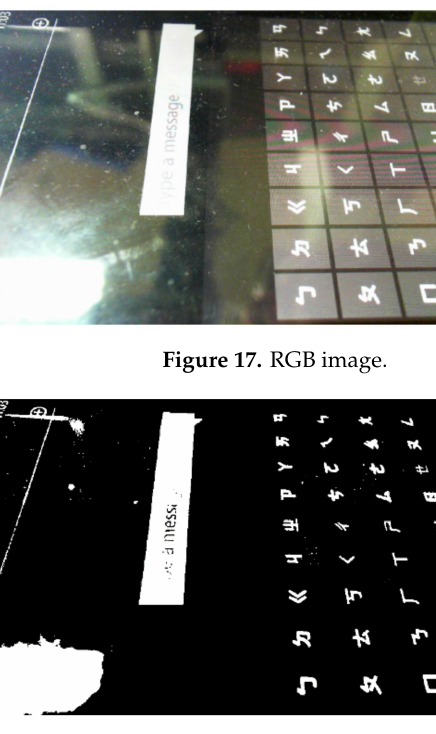
Figure 18. Binary image.